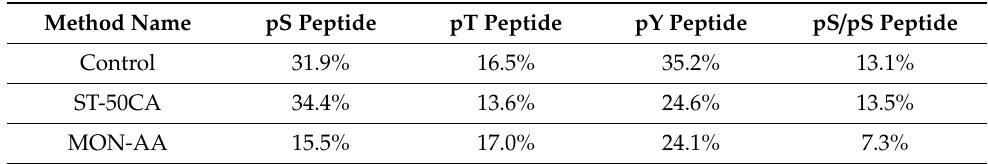
Table 3. Relative standard deviations of model PP peak areas, calculated based on the results of five parallel enrichments.